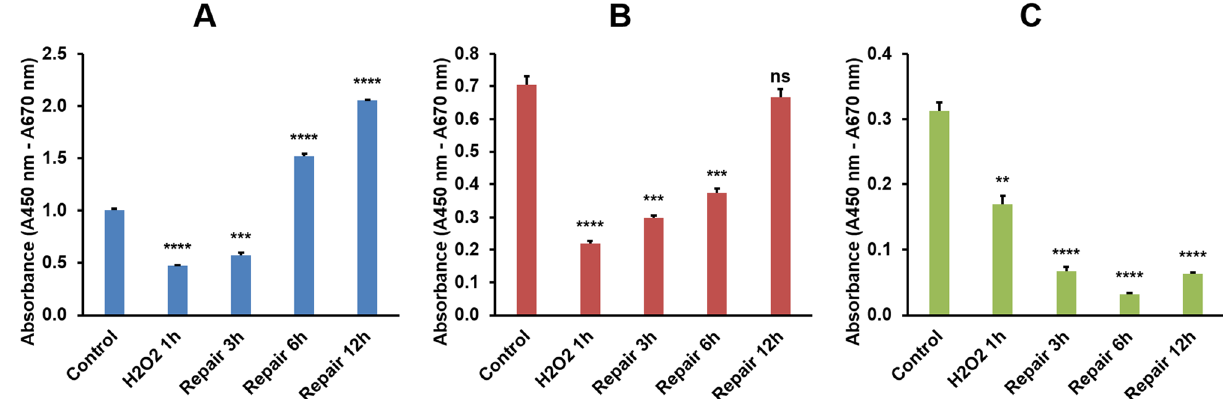
Figure 7. WST-1 assay in CEFs, EGK.X blastoderm cells (BCs), and PGCs treated with H 2 O 2 . The cultured CEFs ( A ), EGK.X blastoderm cells ( B ), and PGCs ( C ) were treated with 1 mM H 2 O 2 for 1 h (H 2 O 2 1 h) in one group. In three other groups, the cells were treated with 1 mM H 2 O 2 for 1 h, and then incubated in fresh media without H 2 O 2 for 3 h (repair 3 h), 6 h (repair 6 h) and 12 h (repair 12 h). After treatment, cells were subjected for WST-1 assay. Significant differences between the respective control and treated samples were determined by Student’s t -test. Statistical significance was ranked as * P < 0.05, ** P < 0.01, *** P < 0.001, or **** P < 0.0001. ns ,